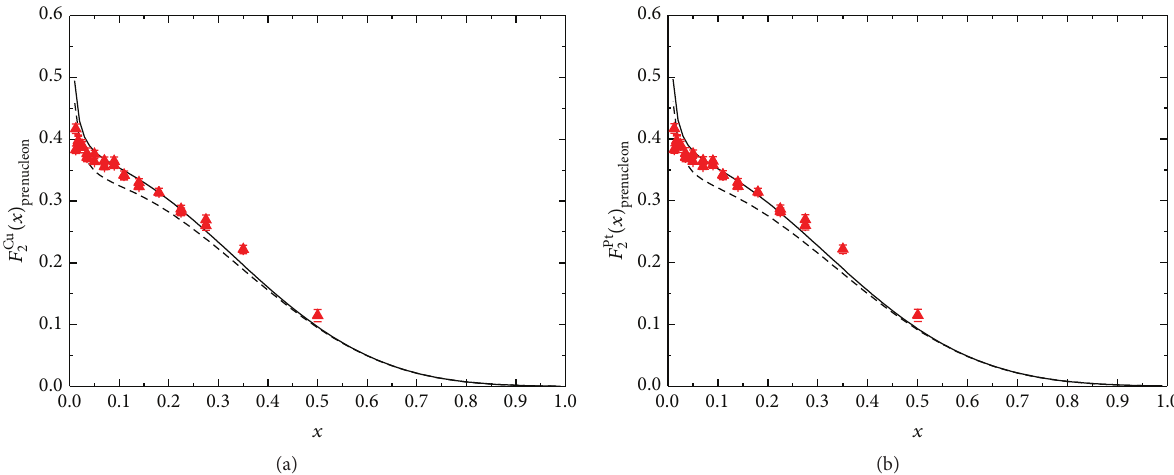
Figure 5: (a) and (b) show 63 Cu and 195 Pt structure functions per nucleon in mean 𝑄 2 = 5 GeV 2 . The full curve is obtained by considering, the Fermi motion, the binding energy, and the pionic contribution effect. The dashed line shows the structure function by considering the Fermi motion and the binding energy. Experimental data shows deuterium structure function per nucleon [19].